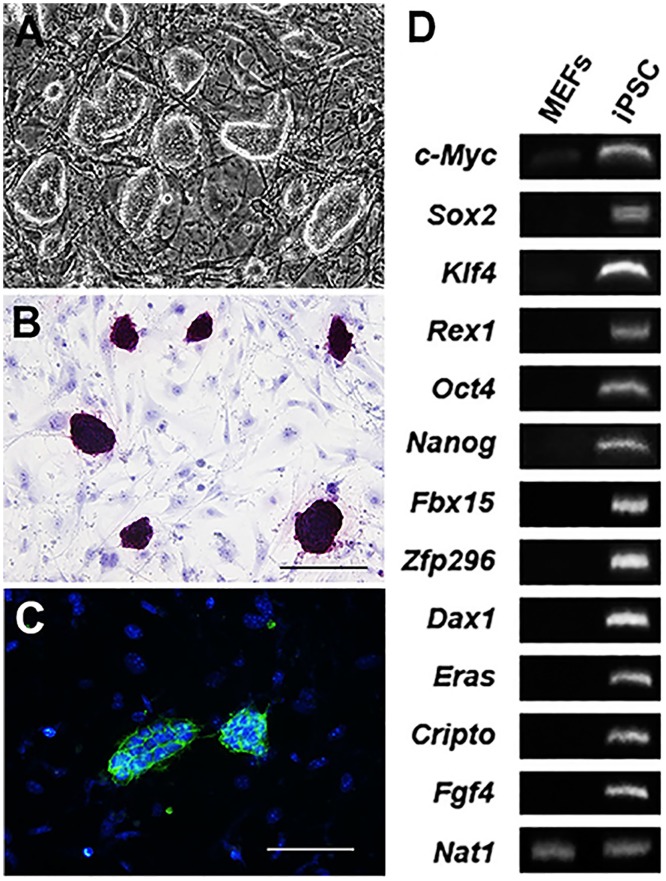
Characterization of murine induced pluripotent stem cells.Murine iPSCs were plated onto mitomycin c-treated MEFs for 3 days and formed cobblestone-like colonies. (B) iPSCs demonstrated specific and strong alkaline phosphatase activity. Scale bar = 100 μm. (C) Immunocytochemistry revealed the expression of iPSC marker SSEA-1. Scale bar = 100 μm. (D) Gel electrophoresis demonstrates the semi-quantitative RT-PCR results for several key genes unique to iPSCs. Nat1 served as an internal control.